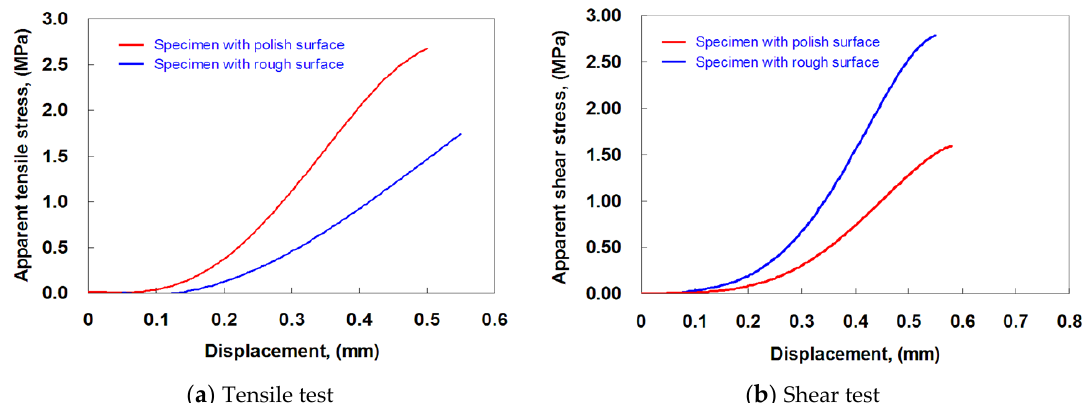
Figure 3. Typical relationship between the surface traction and displacement of the bonded interface under tensile and shear loading, respectively.